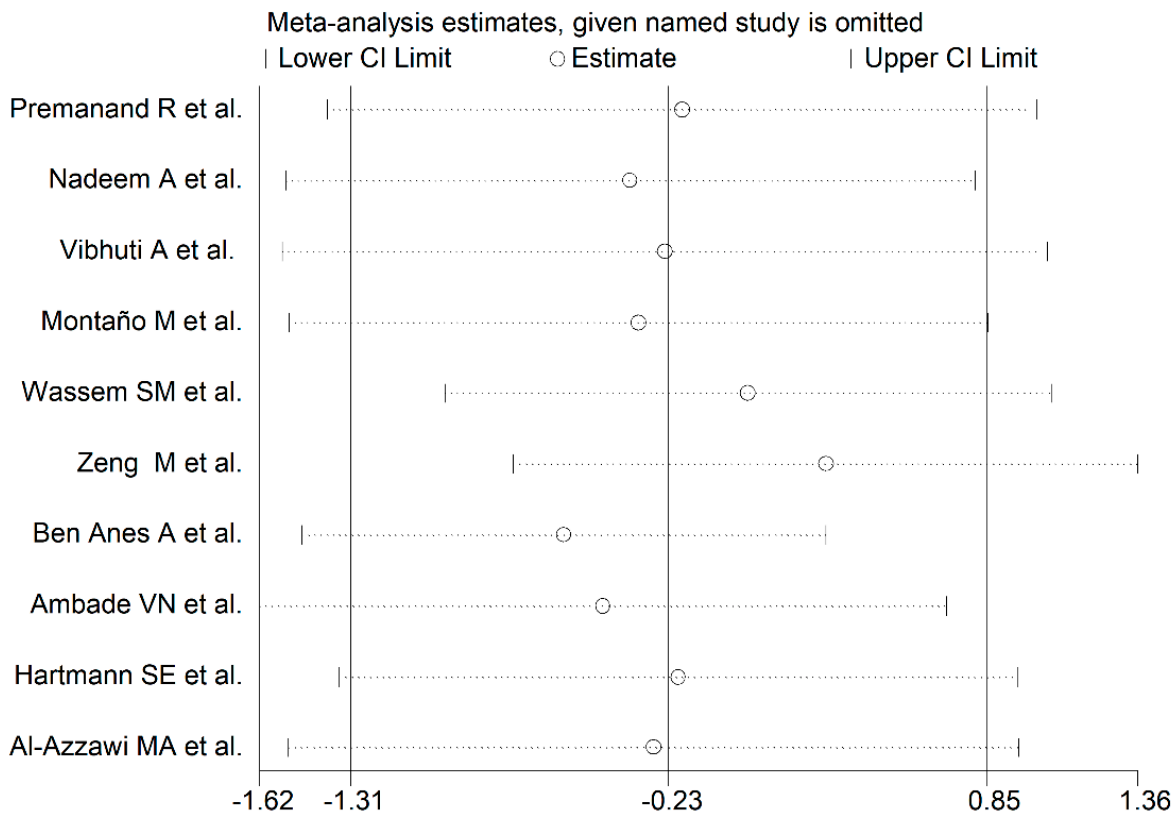
Figure 8. Sensitivity analysis of the association between serum/plasma GPx and COPD disease. For each study, the